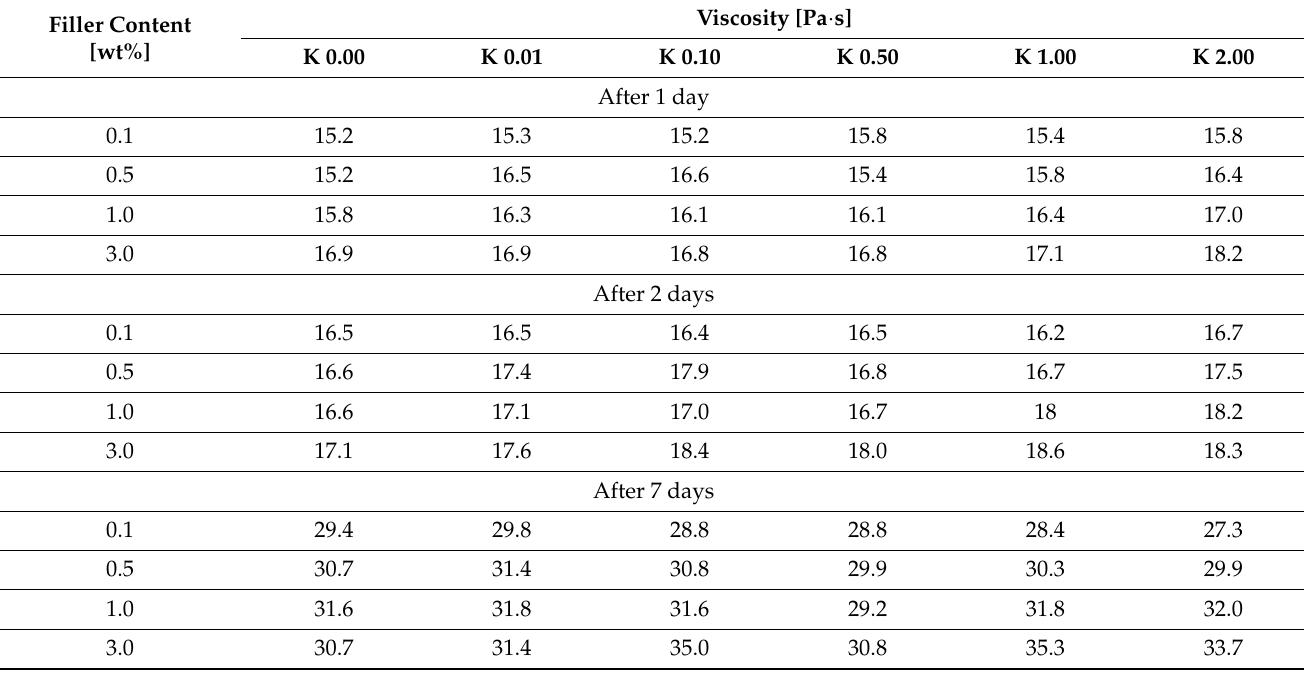
Table 3. The viscosity of Q2-7358 resin-based compositions with